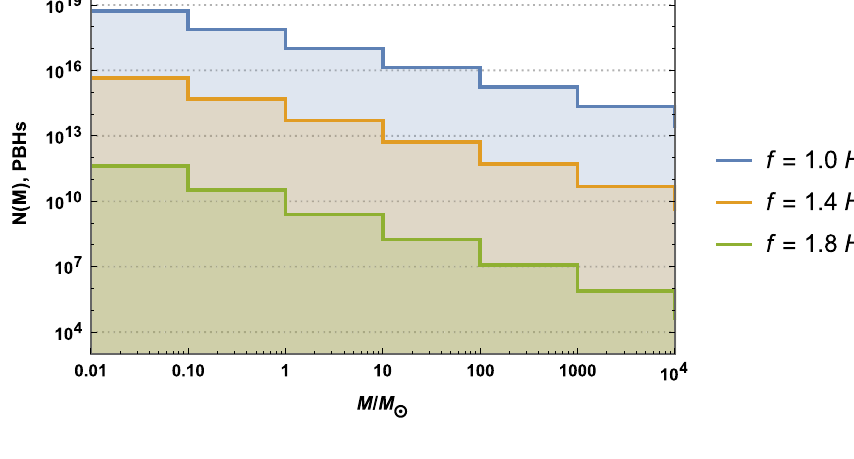
Fig. 1 PBHs mass spectrum for the visible Universe: f = 1 . 4 H line represents realistic PBH distribution. In this case, the number of PBHs with a mass ∼ 10 2 M (cid:2) corresponds to the number of galaxies in the observable Universe. The role of other lines is to demonstrate a strong dependence of the distribution on the parameter f